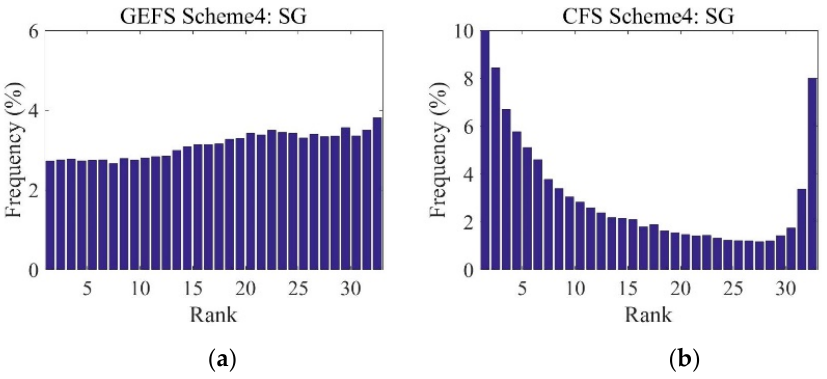
Figure 10. RHs of Shaoguan under the Scheme 4: ( a ) GEFS; and ( b ) CFSv2.